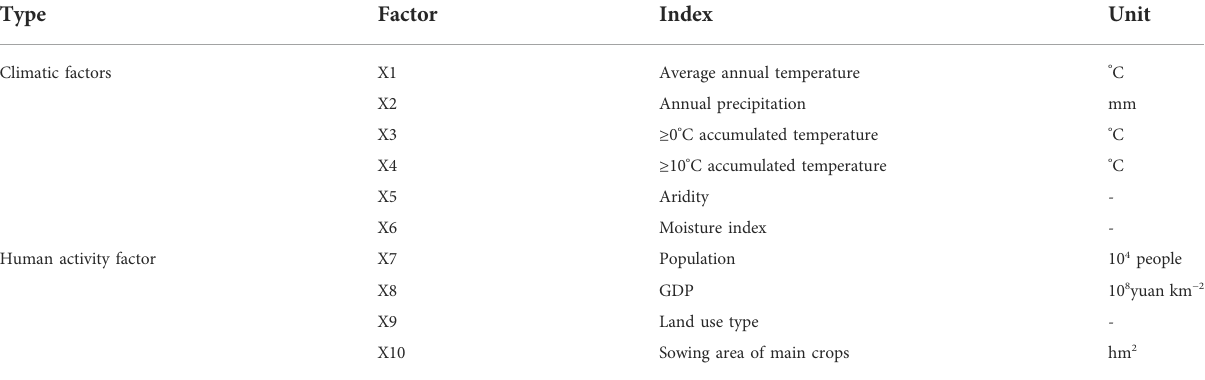
TABLE 3 Selection of vegetation NDVI in fl uencing factors in the three northeast